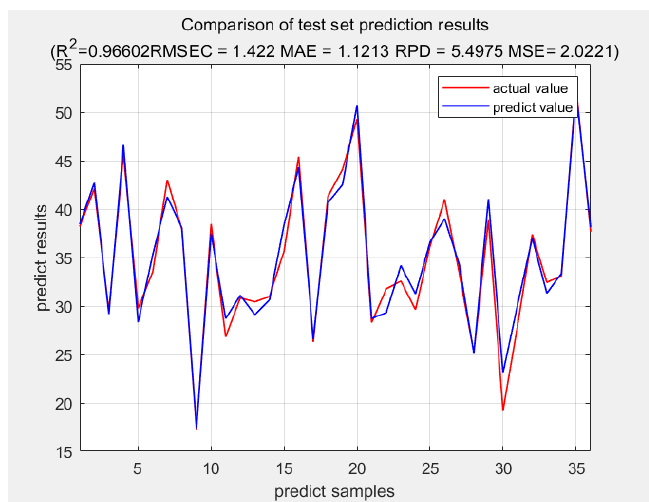
Figure 11. Actual value and predicted value in test set.